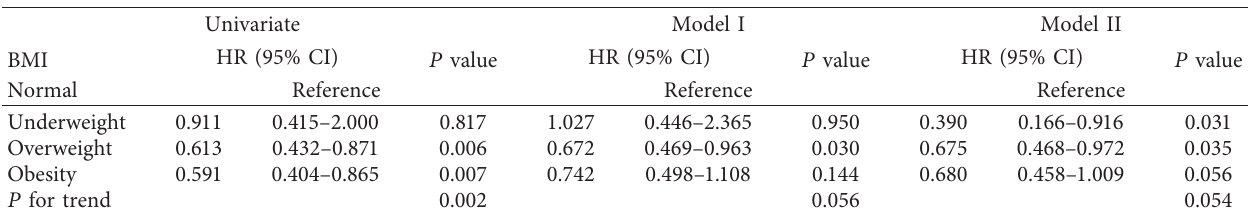
Table 3: Cox regression analyses of the relationship between BMI and all-cause mortality for patients after PCI. Univariate